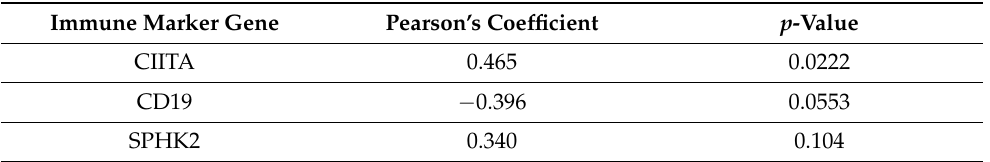
Table 4. Apoptosis e ff ector gene expression, inverse correlations with GBM TCR CDR3-SPAG9 Fragment 6 electrostatic CSs.